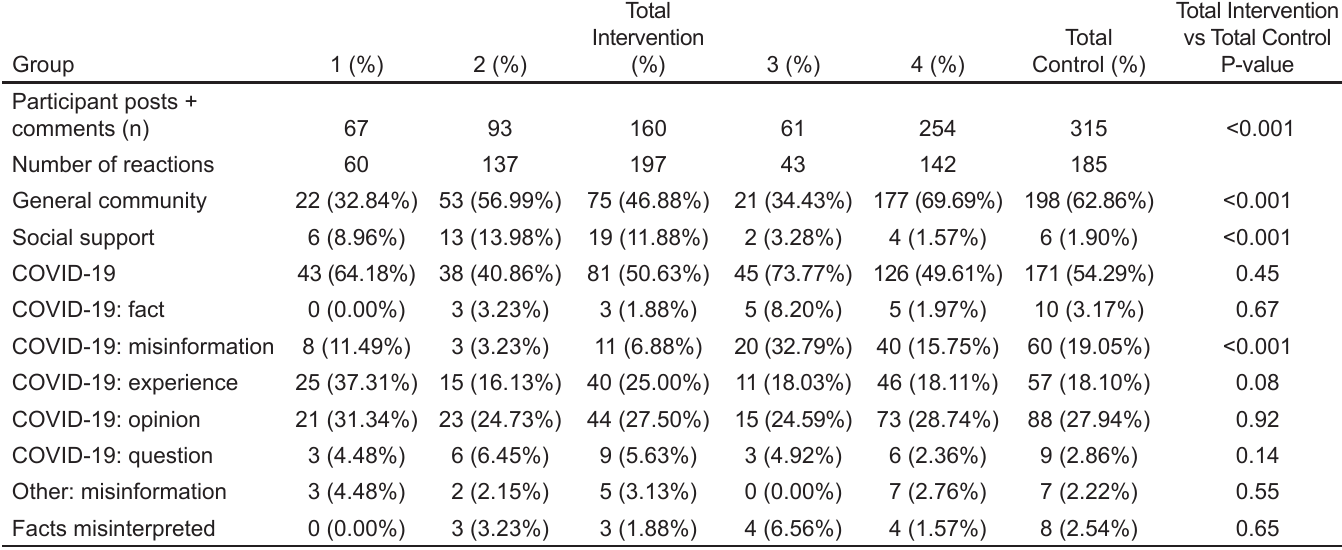
Table 2. Coded conversation topics of participant posts and